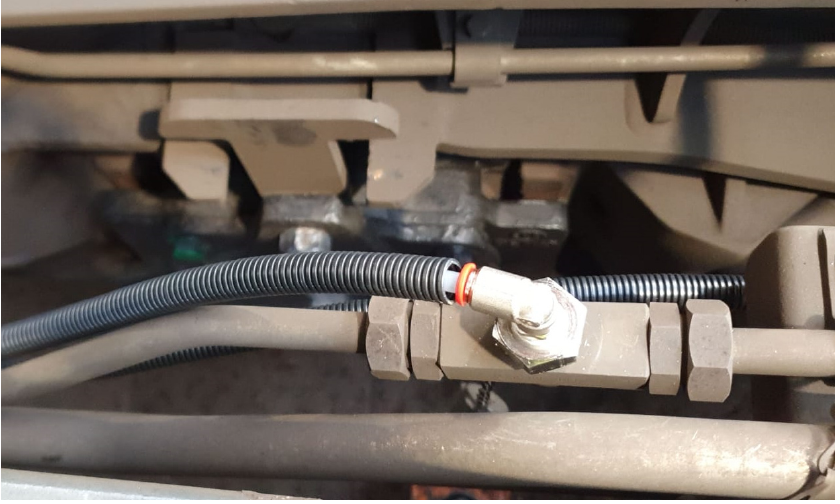
Figure 8. Mechanical connections.